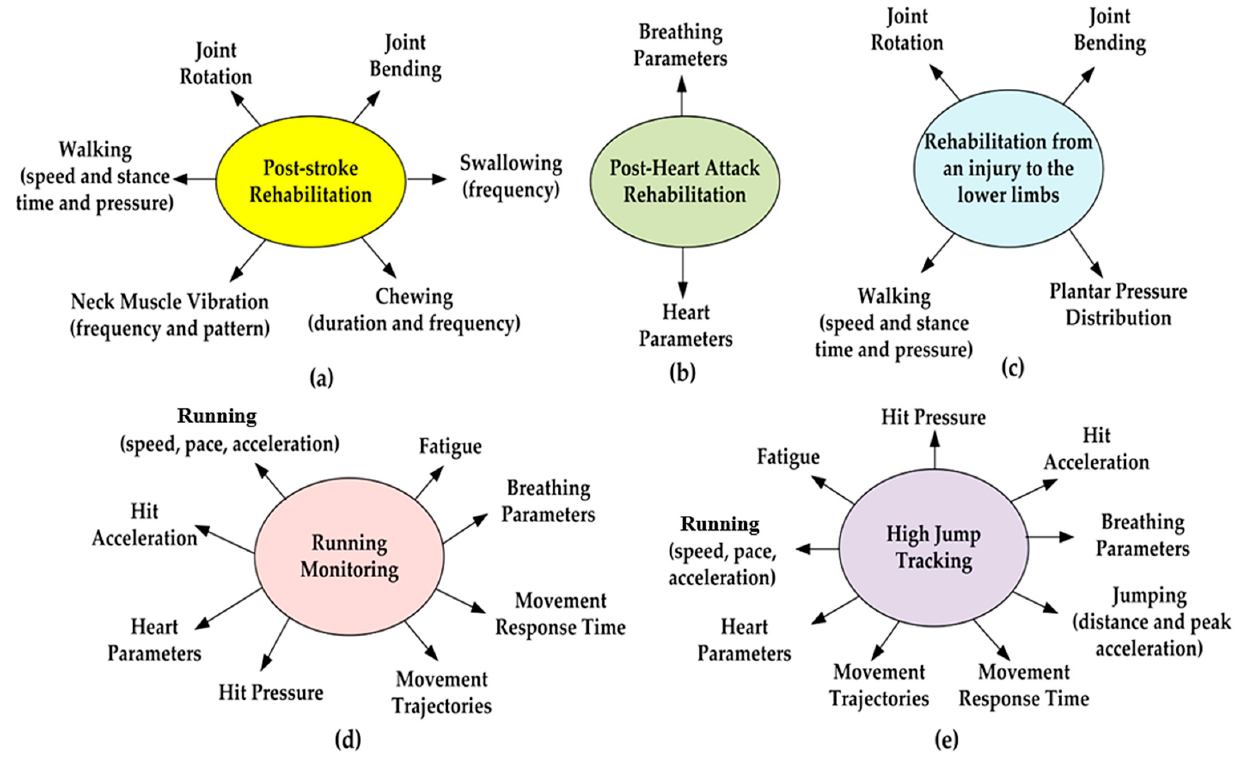
Figure 5. Plots representing the parameters and gestures monitored for the different typologies of clinical rehabilitation: post-stroke ( a ), post-heart attack ( b ) and rehabilitation from an injury to the lower limbs ( c ). Parameters and gestures monitored in sports activity: running monitoring ( d ) and high jump tracking ( e ).